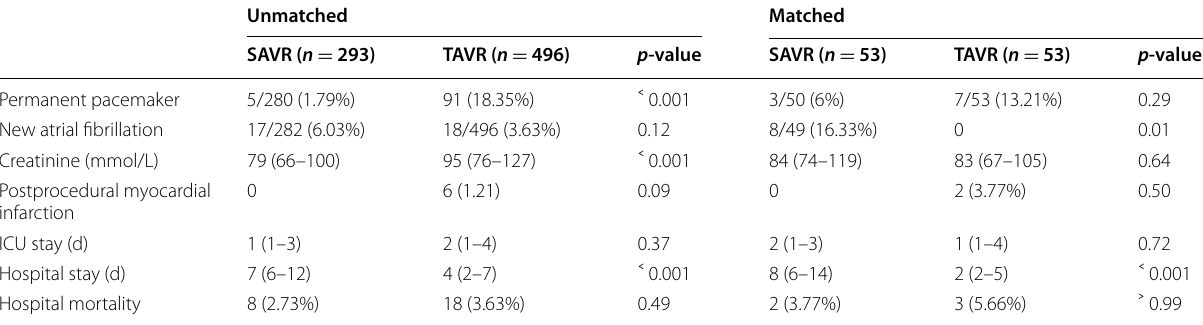
AR Aortic regurgitation, AS Aortic stenosis, AV Aortic valve, BMI Body mass index, LV Left ventricle, LVEDD Left ventricular end-diastolic diameter, LVESD Left ventricular end-systolic diameter, MI Myocardial infarction, NYHA New York Heart Association, PCI Percutaneous coronary interventions, SMD Standardized mean difference. Data were presented as mean and standard deviation or median (interquartile limits) for continuous data or numbers and percentages for categorical data Table 2 Comparison of hospital outcomes between patients who had surgical vs. transcatheter aortic valve replacement before and after matching ( SAVR , surgical aortic valve replacement; TAVR , transcatheter aortic valve